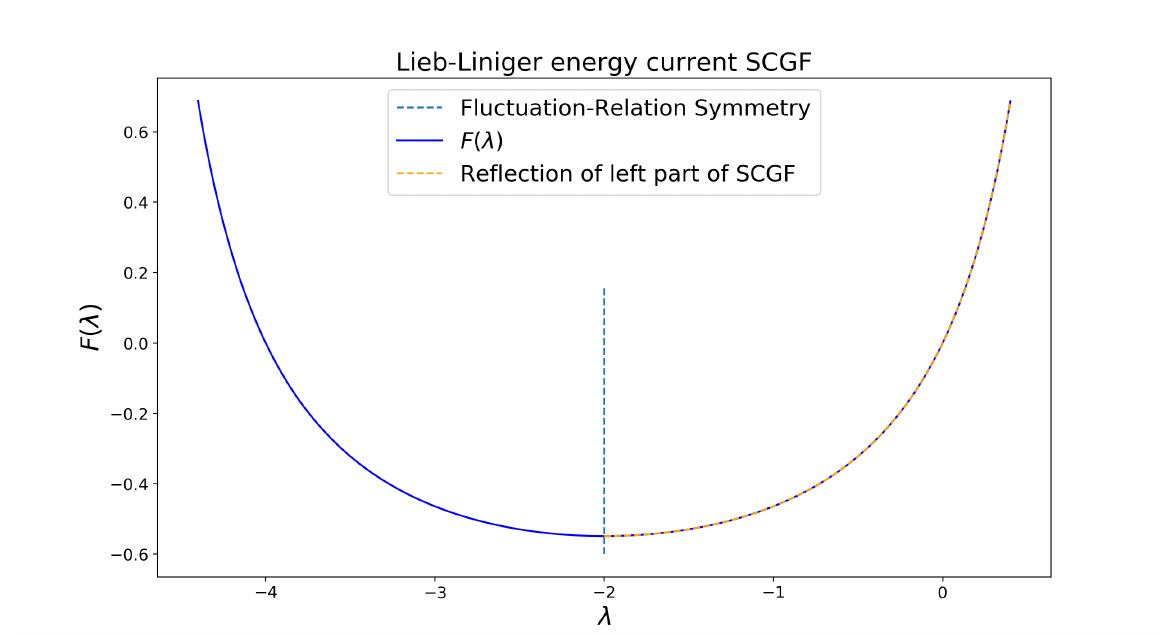
Figure 3: Numerical evidence for the fluctuation-relation symmetry in the Lieb- Liniger gas. Plot of the energy flow SCGF for the Lieb-Liniger model using (25). = 1, β = 5, c = 1. The fluctuation-relation For this plot the parameters used are β l r − β ) / 2, as indicated by the dotted symmetry point is ( β l r